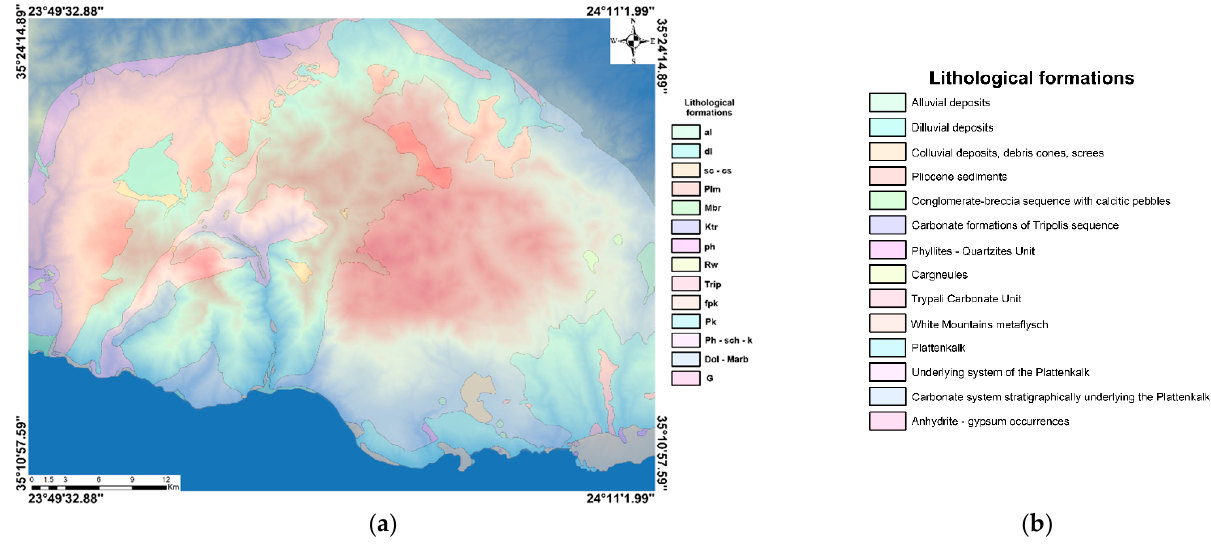
Figure 5. The 2nd geological model for the wider Samaria area (modified from Pavlaki and Perleros, 2015 [5]): ( a ) Lithological map of the study area; ( b ) Description of the geological formations.